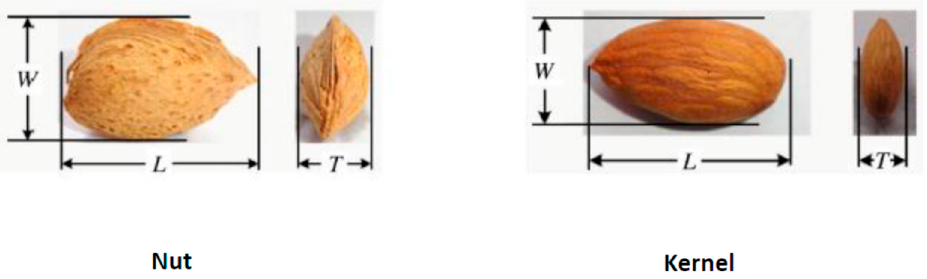
Figure 1. Measurements of in shell almond and kernel traits carried out before starting the storage trials following the guidelines proposed by Zheng and Fielke, 2014 (L = length; W = width; T = thickness).